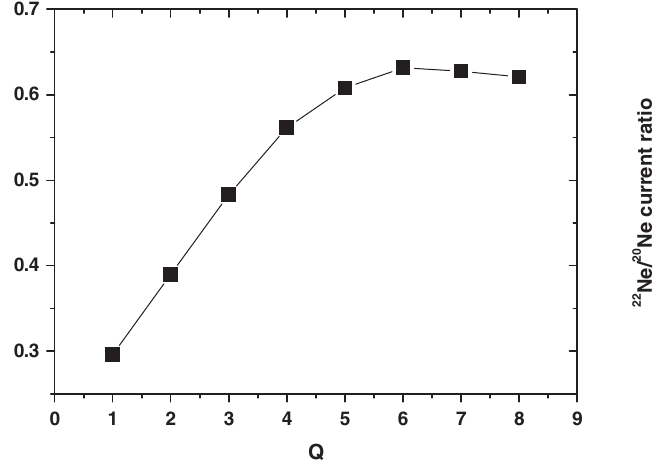
FIG. 11. Ratio between the extracted currents of 22 Ne and 20 Ne ions as a function of the charge state. FIG. 10. Dependence of the mean confinement time on the ion